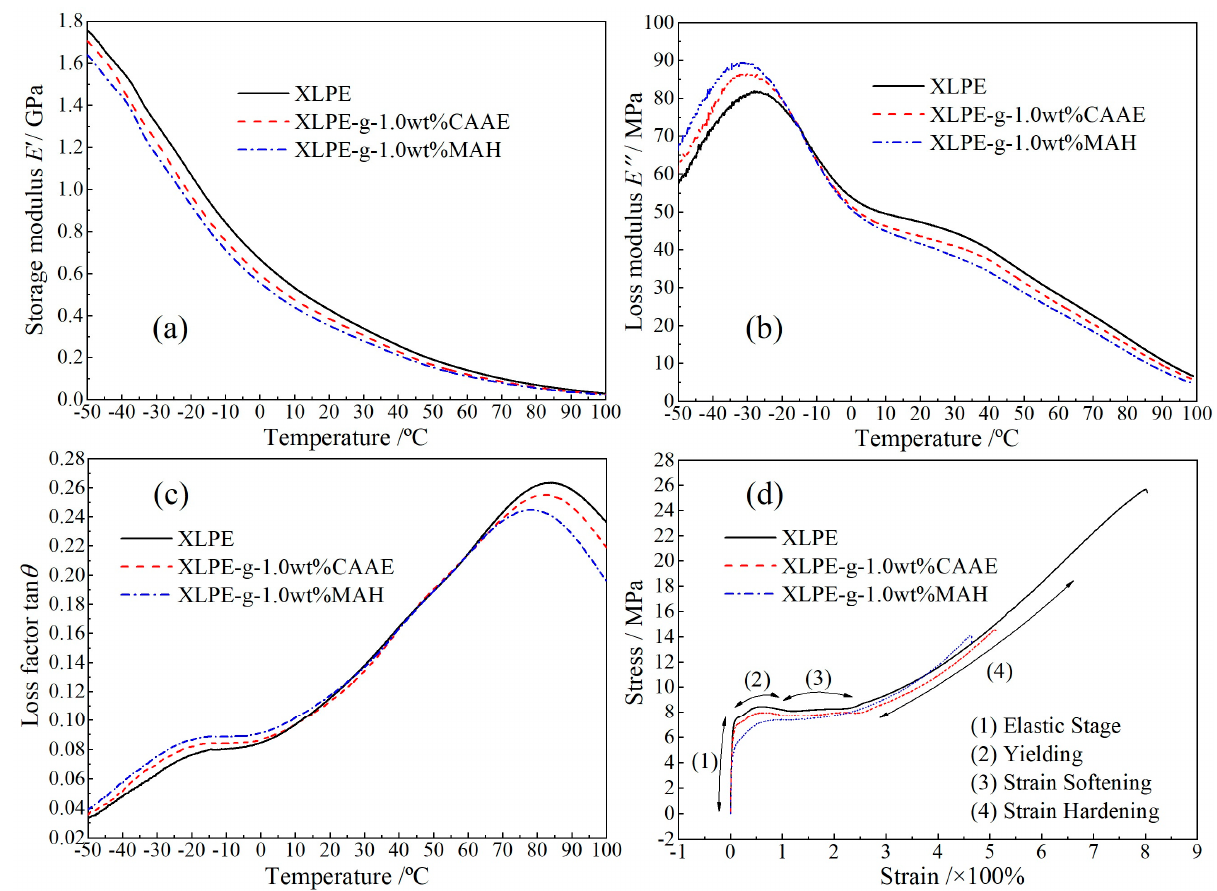
Figure 5. DMA temperature spectra of ( a ) storage modulus, ( b ) loss modulus, ( c ) loss factor and ( d ) stress-strain characteristics for XLPE-g-1.0wt%CAAE and XLPE-g-1.0wt%MAH in comparison to XLPE benchmark. Table 2. DMA β relaxation peak magnitude (loss modulus E ” and factor tan θ ), crystallinity X c and water-tree dimension (characteristic length L c ).